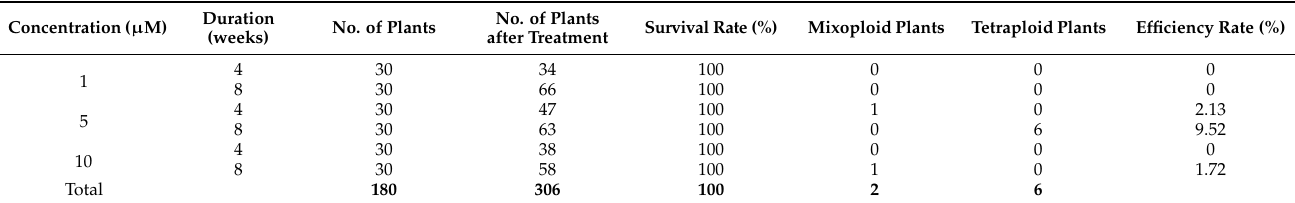
Table 1. Effect of oryzalin treatment on polyploid induction of Callisia fragrans .